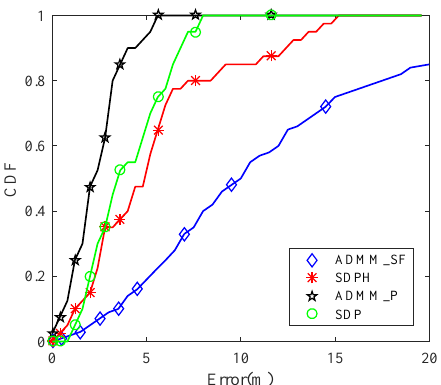
Figure 3. Cumulative Distribution Function (CDF) comparison of the four aforementioned methods for a M = 10, N = 40 sensor network. Anchors were randomly distributed. Probability of NLOS connections was set to P NLOS = 95%.